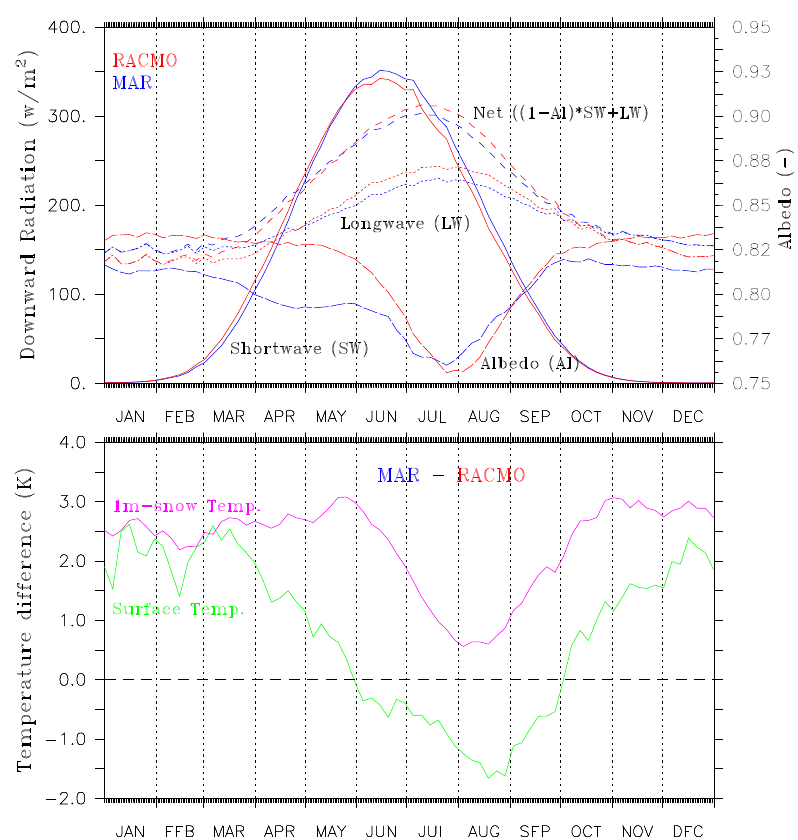
Fig. 6. Top – time series of the mean shortwave (solid line), longwave (dotted line), albedo (dashed line on right y-axis) and net radiation (dashed line) averaged over the melting zone of the GrIS (i.e. surface height below 2500m) and over the period 1979–2009 simulated by MAR (in blue) and by RACMO2 (in red). Below) Time series of the mean difference in surface temperature (resp. the temperature of the top meter of snow) between MAR and